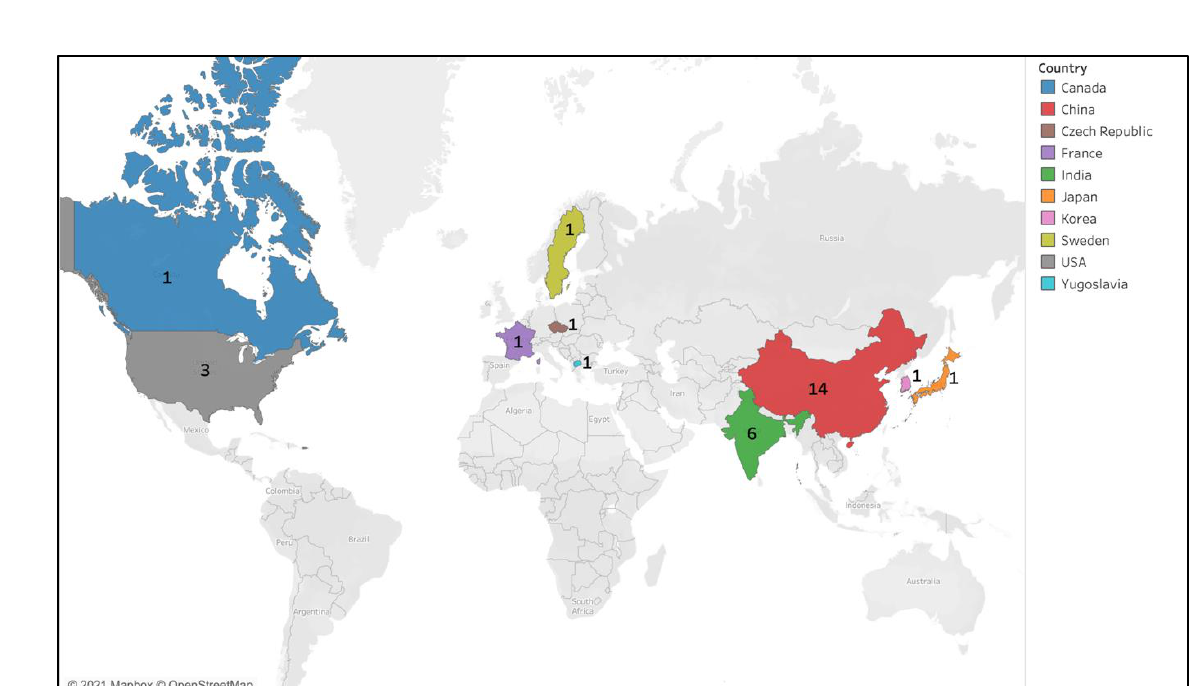
Figure 2. Geographical distribution of the selected studies, indicating the number of publications.